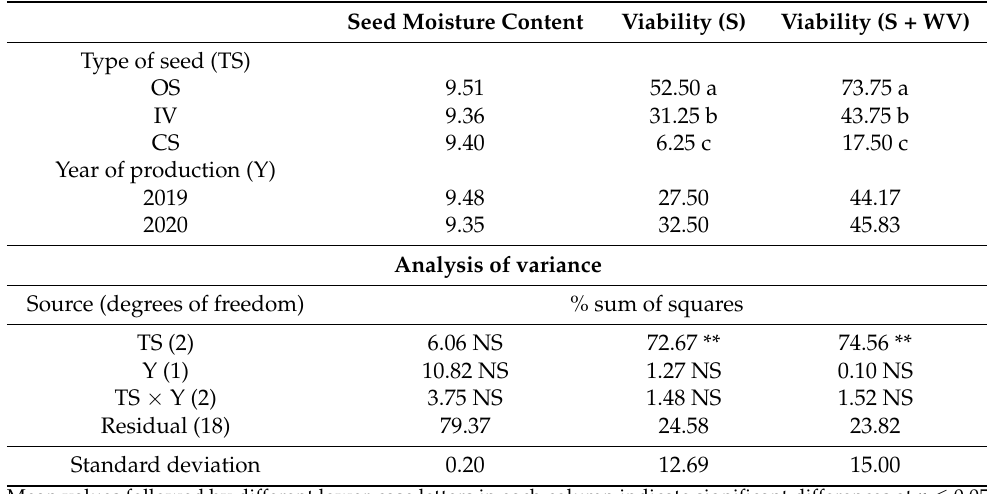
Table 1. Effect of the type of seed (own produced (OS), type IV, and commercial (CS)) and the year of production on the seed moisture content (%) at starting the viability and germination tests and on the viability of the seeds (%), considering both the sound seeds (S) and the sound and weak but viable tissues (S + WV) criteria; mean values. Seed Moisture Content Viability (S) Viability (S + WV) Type of seed (TS)